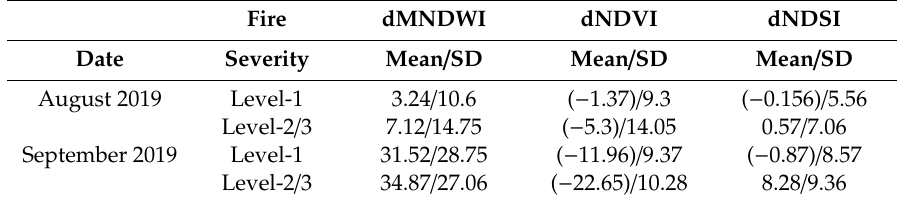
Table 6. The dynamic rate of ecological indexes and fire severity. Unit: %. dMNDWI: di ff erence in Modified Normal Di ff erential Water Index; dNVDI: di ff erence in Normalized Vegetation Di ff erence Index; dNDSI: di ff erence in Normalized Di ff erence Soil Index.